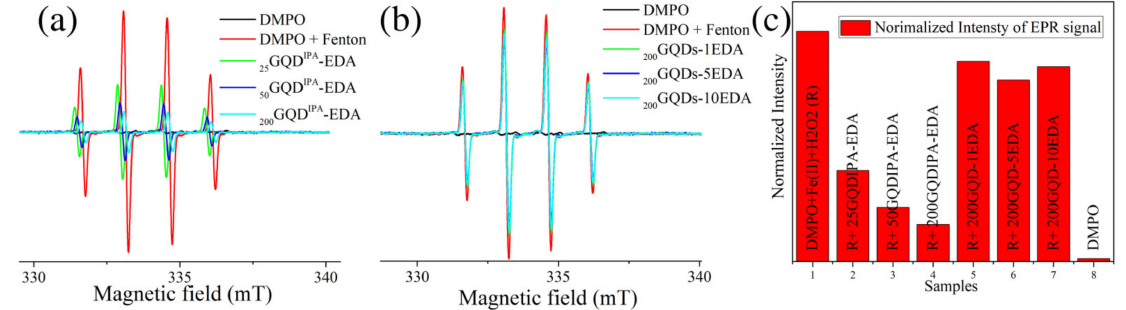
Figure 10. DMPO assay for OH-scavenging activity: EPR spectra of DMPO, Fe 2+ , and H 2 O 2 mixed with 25 GQD IPA -EDA, 50 GQD IPA -EDA, and 200 GQD IPA -EDA ( a ), or 200 GQDs-1EDA, 200 GQDs-5EDA and 200 GQDs-10EDA ( b ); normalized intensities of DMPO–OH signals ( c ).